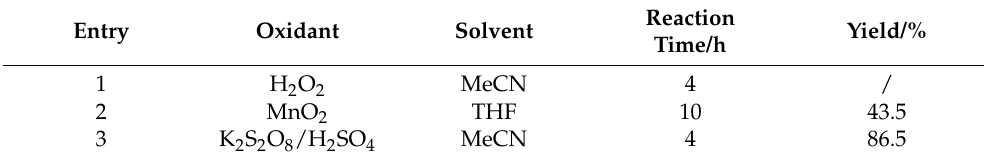
Table 1. Effects of reaction conditions on the synthesis of compound 5